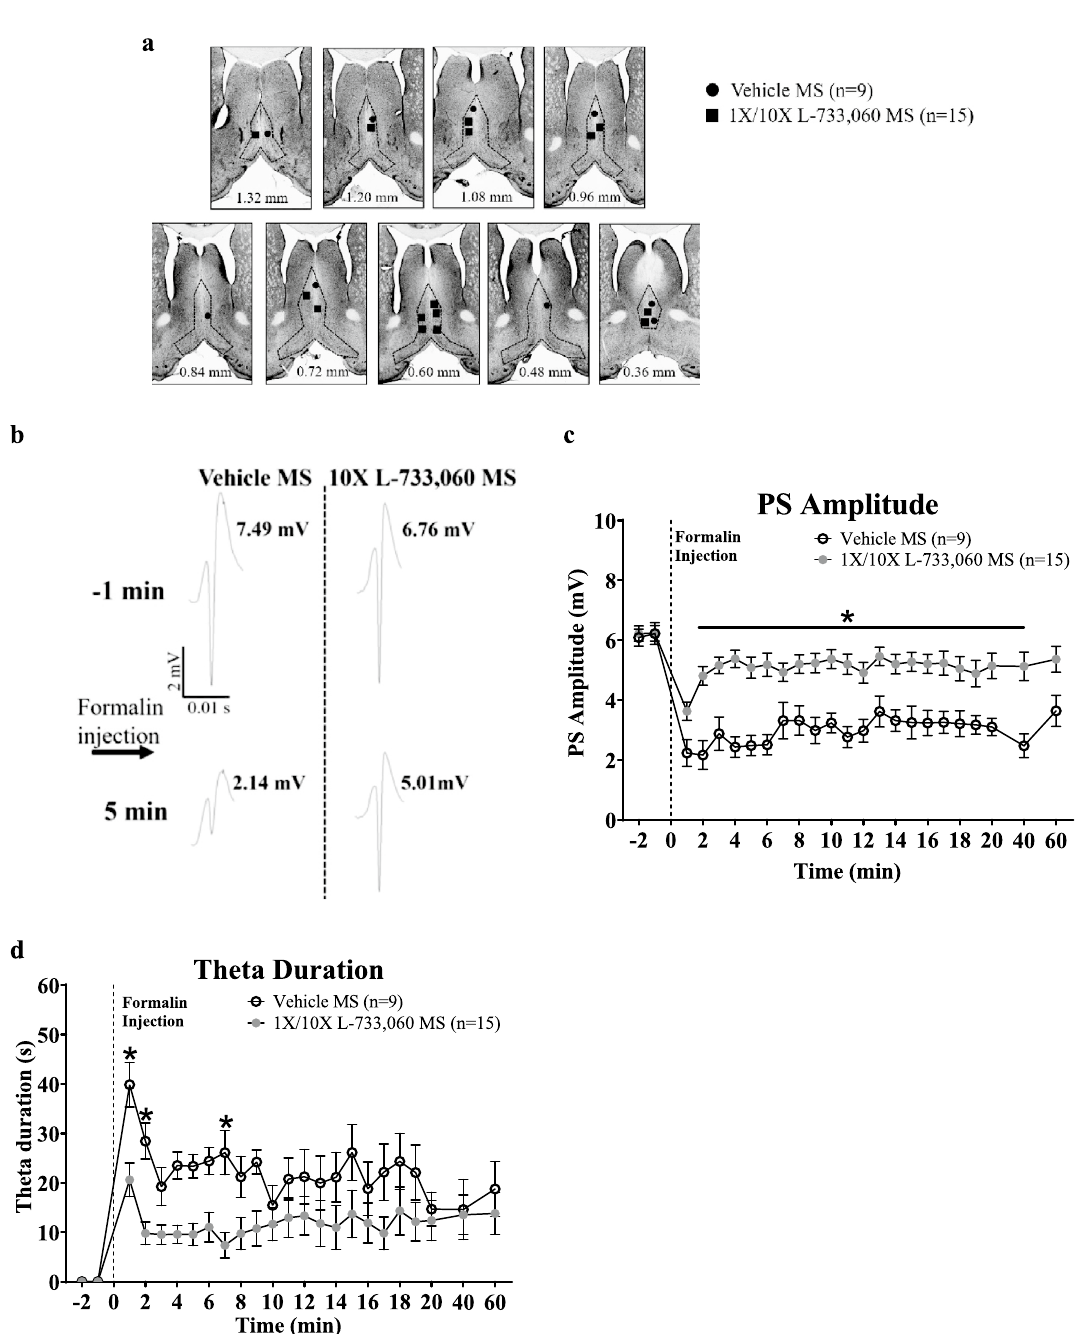
Figure 5. Microinjection of L-733,060 into the medial septum (MS) attenuated formalin-evoked suppression of CA1 PS and theta activation in anaesthetized animals. Formalin (5%, 0.05 ml) was injected subcutaneously into right hind paw 15 min after intraseptal microinjection of vehicle (n = 9) or the NK1R antagonist, L-733,060 (1 ×, 0.0176 µg/µl, n = 8; 10 ×, 0.176 µg/µl, n = 7) during period of large irregular hippocampal field activity (LIA). ( a ) Composite representation of microinjection sites in MS built as in Fig. 1. ( b ) Microinjection of L-733,060 into MS attenuated formalin-induced suppression of CA1 PS. The PS traces are built as in Fig. 3. ( c , d ) Time course of effect of pre-treatment with vehicle or L-733,060 on SP-induced suppression of PS ( c ) and duration of theta wave activity ( d ). The duration of theta reflects the cumulative duration of theta segments of at least 1 s length in blocks of 1 min. Data are mean ± S.E.M. Significant difference (p < 0.05): * vs. Vehicle MS; two-way RM ANOVA followed by Bonferroni post-hoc